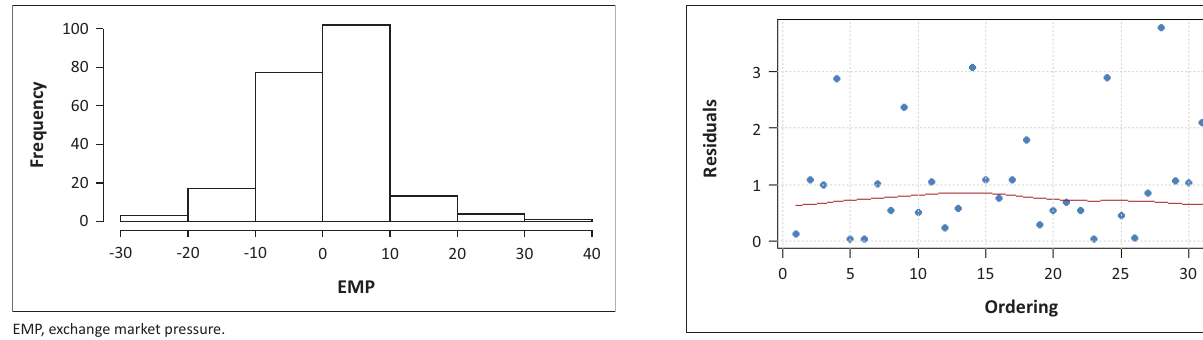
FIGURE 9: South Africa – Diagnostic plot for peak over threshold analysis: Scatterplot of the residuals.